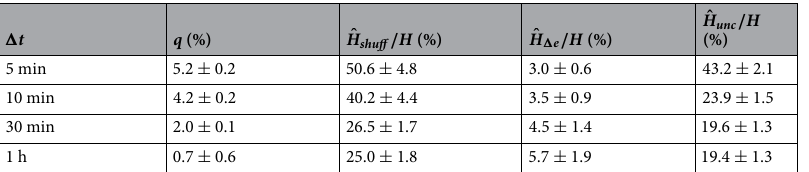
Table 1. Comparison of average actual entropy estimation errors from incomplete mobility sequences for q ≤ 0.60 using three approaches ˆ H shuff , ˆ H (cid:31) e , ˆ H unc . Estimations are compared to the real entropy H calculated on complete movement sequences and at different levels of temporal aggregation (cid:31) t . q is an average fraction of missing data in movement trajectories used in the experiment. A 95% confidence interval across the sequences is presented next to the average values of